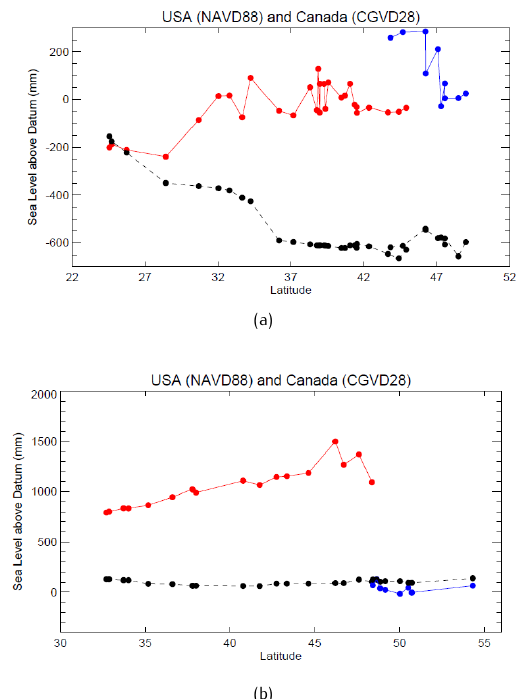
Figure 2. (a) MSL values for the Atlantic coast of the USA and Canada for the period 1993-2002 shown by red and blue dots and measured relative to NAVD88 and CGVD28 re- spectively. Note that at Rimouski (48.48 ◦ N) the MSL is approximately zero with respect to CGVD28, whereas the five Canadian values with large MSL are in Nova Scotia. Black dots show MDT from the Liverpool-MIT ocean circu- lation model. (b) A similar set of points for the Pacific coast of North